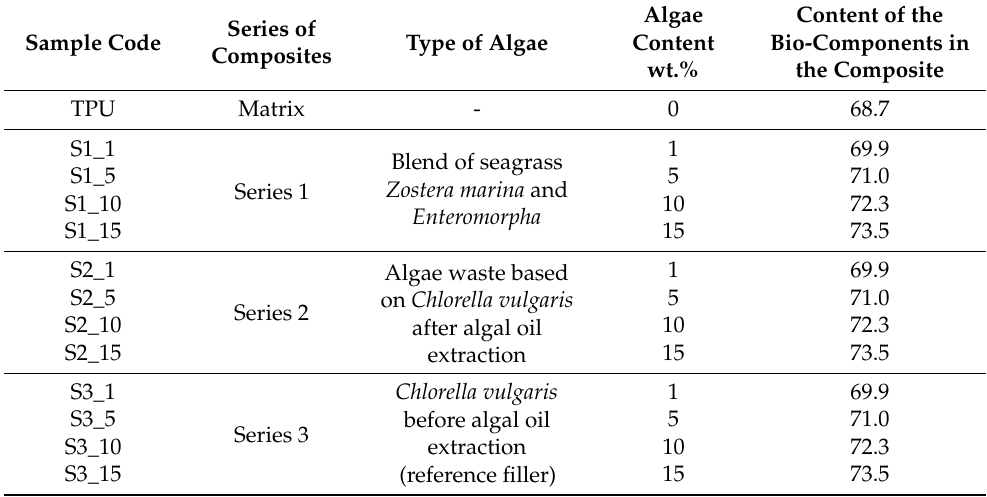
Table 4. Sample description: codes, series and content of the bio-components in the